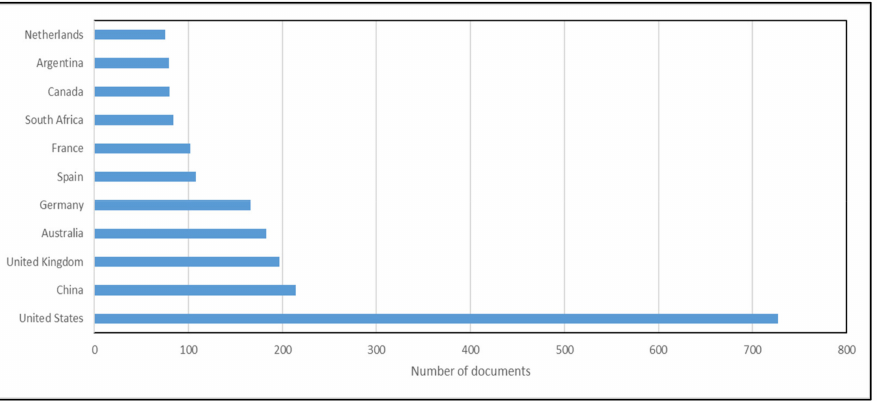
Figure 2. Scientific production addressing the topic of ecosystem services in pastoral husbandry by country, as obtained from the search in Scopus. The countries included are those in which more than 70 documents have been published.